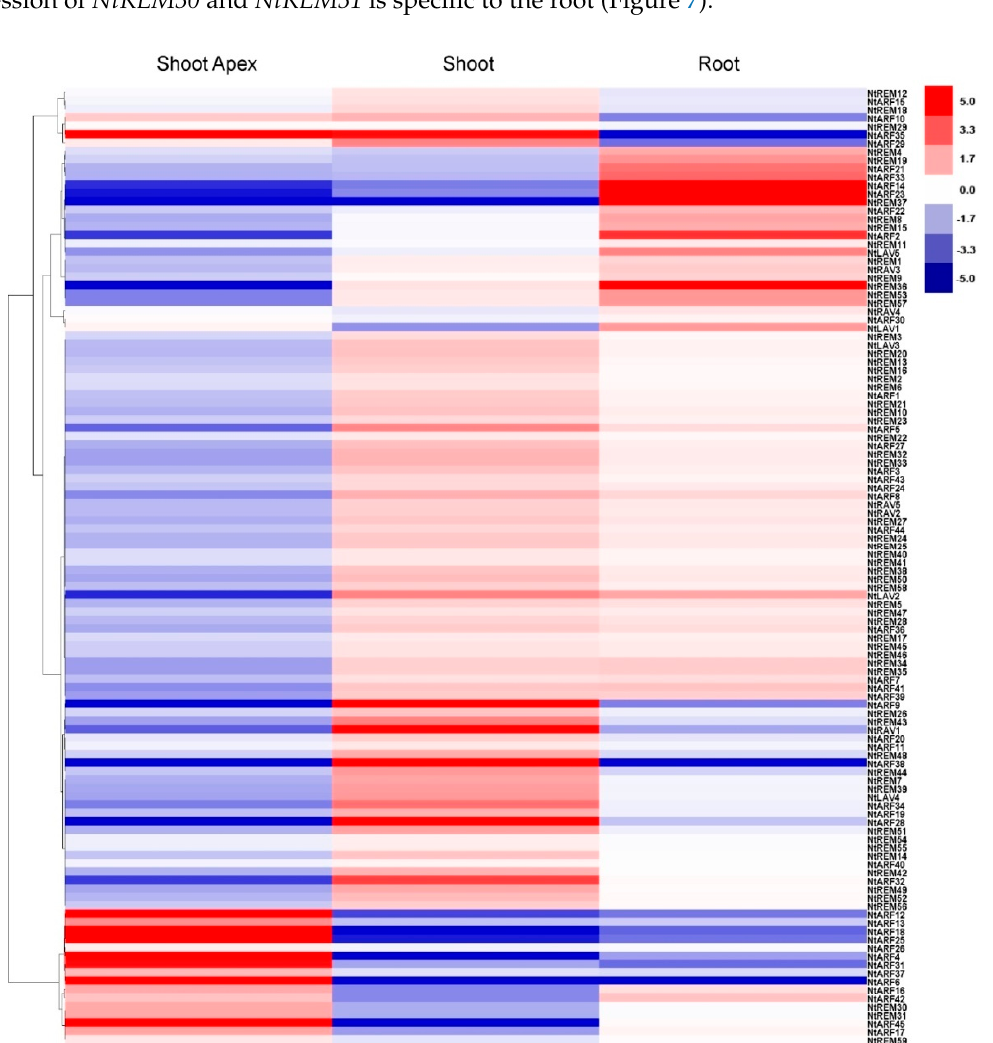
Figure 6. Expression profile analysis of B3 genes in tobacco tissues from the seedling stage.